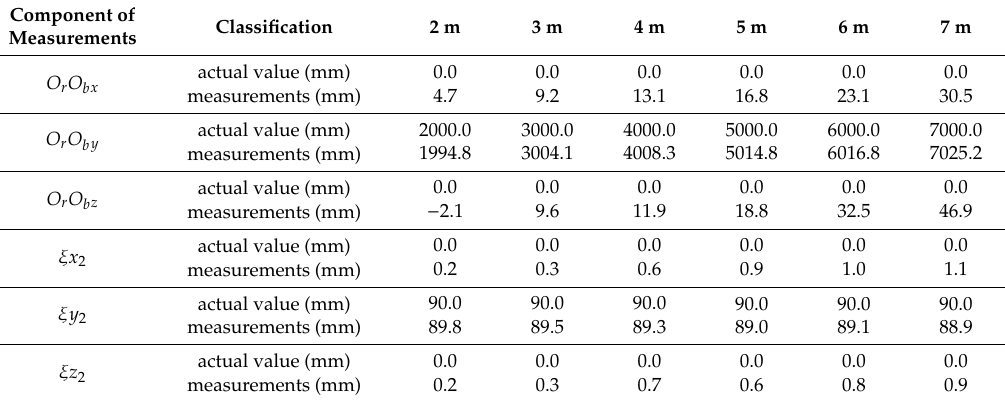
Table 2. Experimental data of measuring devices based on flange center positioning. Component of